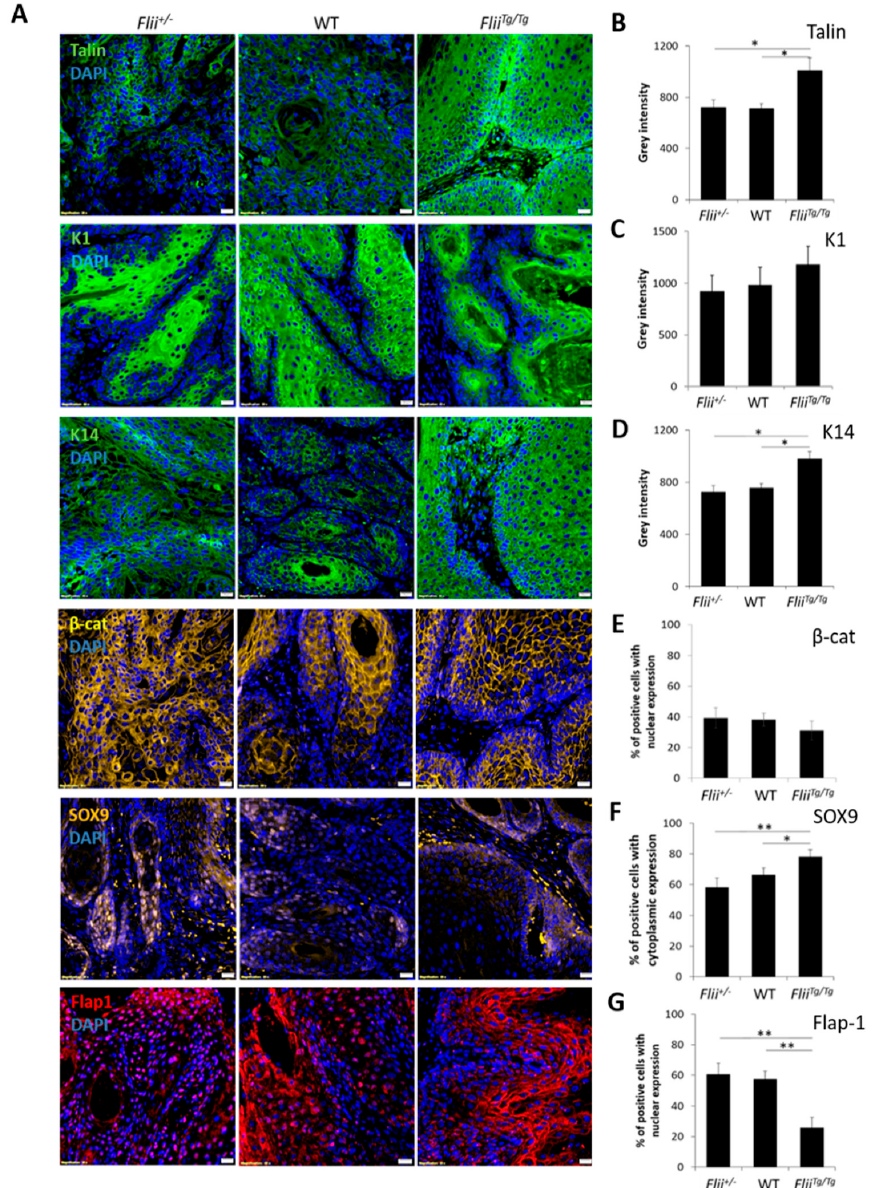
Figure 5. Overexpression of Flii promotes a poorly differentiated phonotype of tumorigenesis in cSCC. Immunofluorescence and quantification of talin (green) ( A , B ), K1 (green) ( A , C ), K14 (green) ( A , D ), β -catenin (yellow) ( A , E ), SOX9 (yellow) ( A , F ), Flap1 (red) ( A , G ) and DAPI (blue) ( A ) in sections of murine cSCC tumors of Flii +/ − , wild-type and Flii Tg/Tg mice. Scale bars, 20 μ m. Quantification of staining reveals increased talin, K14 and cytoplasmic SOX9 expression in Flii Tg/Tg mice with concurrent decrease in nuclear Flap1 expression suggestive of poorly differentiated tumors. Two-tailed paired Student’s t-test. Mean ± SEM. n = 10. * p < 0.05, ** p < 0.005.